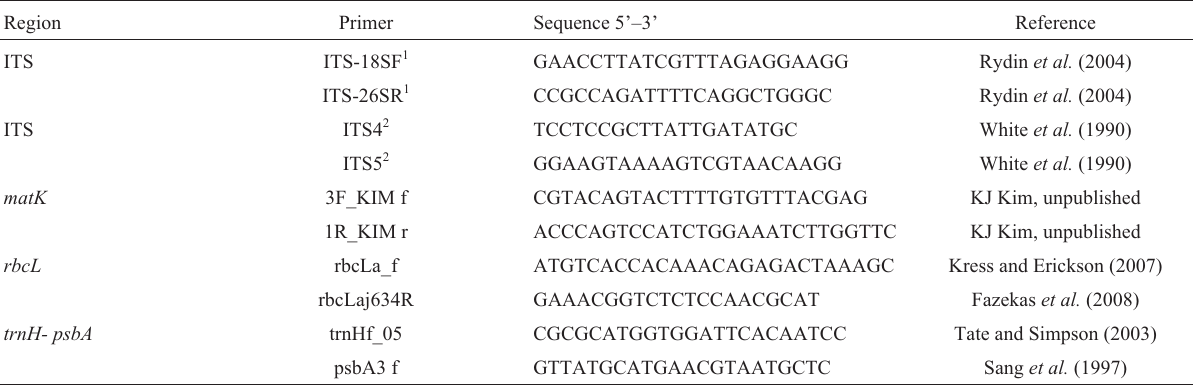
Table 1 - Primers used in PCR and